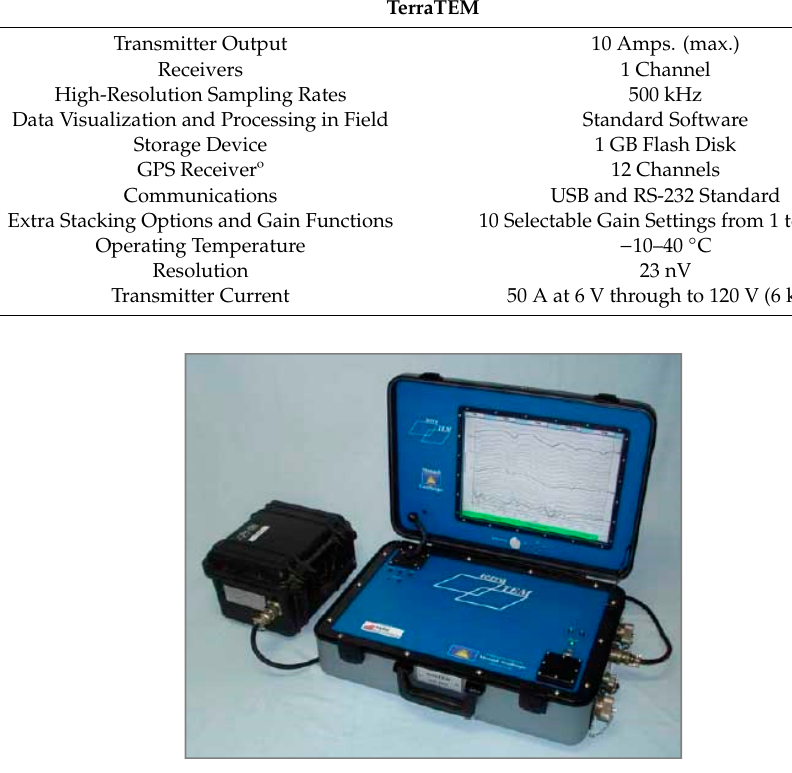
Figure A1. TerraTEM device used in the electromagnetic survey of this research.